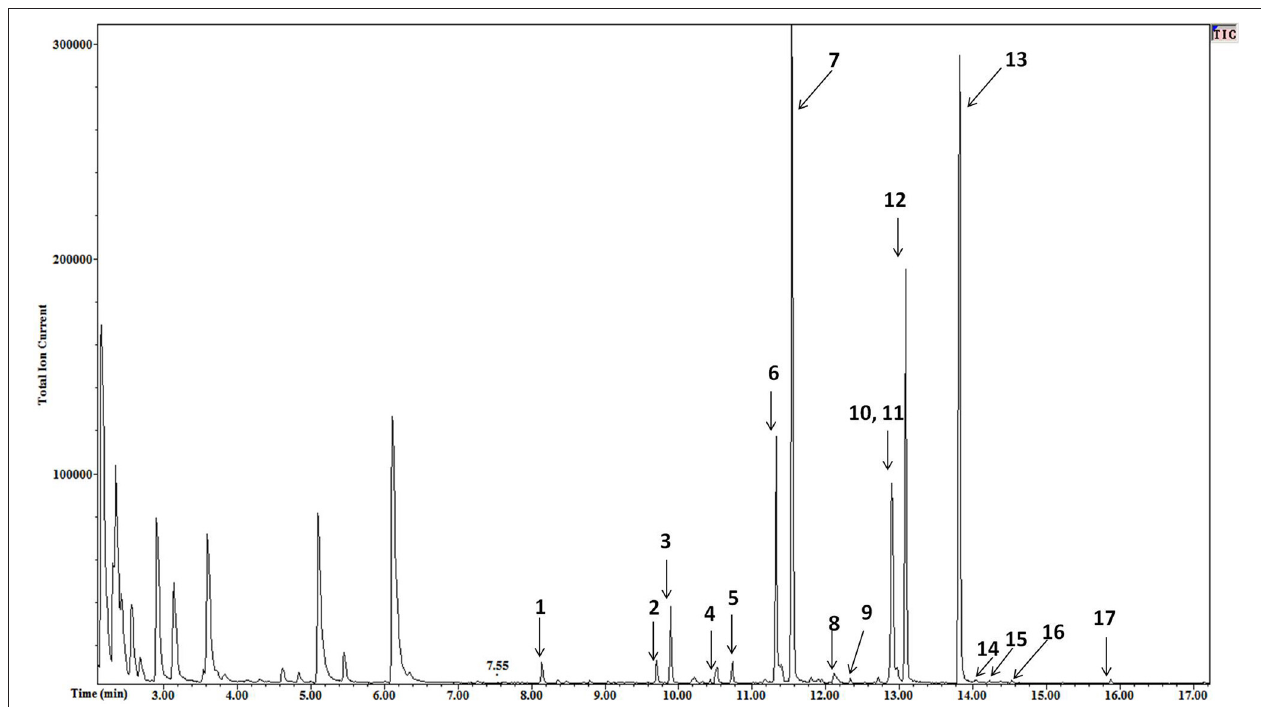
FIGURE 1 | Mass chromatogram of resting saliva. The peaks of NEFA derivatives are numberedas follows 1 = lauric, 2 = myristoleic, 3 = myristic, 4 = pentadecenoic,5 = pentadecanoic,6 = palmitoleic, 7 = palmitic, 8 = heptadecaenoic,9 = margaric, 10 = linoleic, 11 = oleic, 12 = stearic,